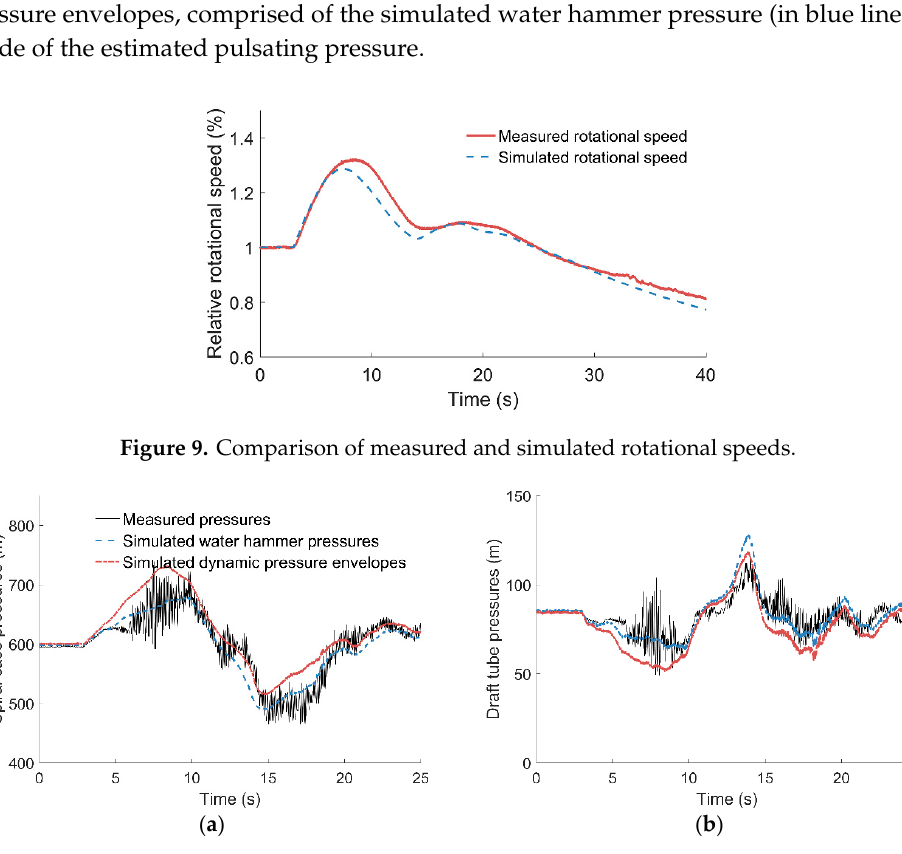
Figure 10. Comparison of measured and simulated pressures at ( a ) spiral case and ( b ) draft tube.